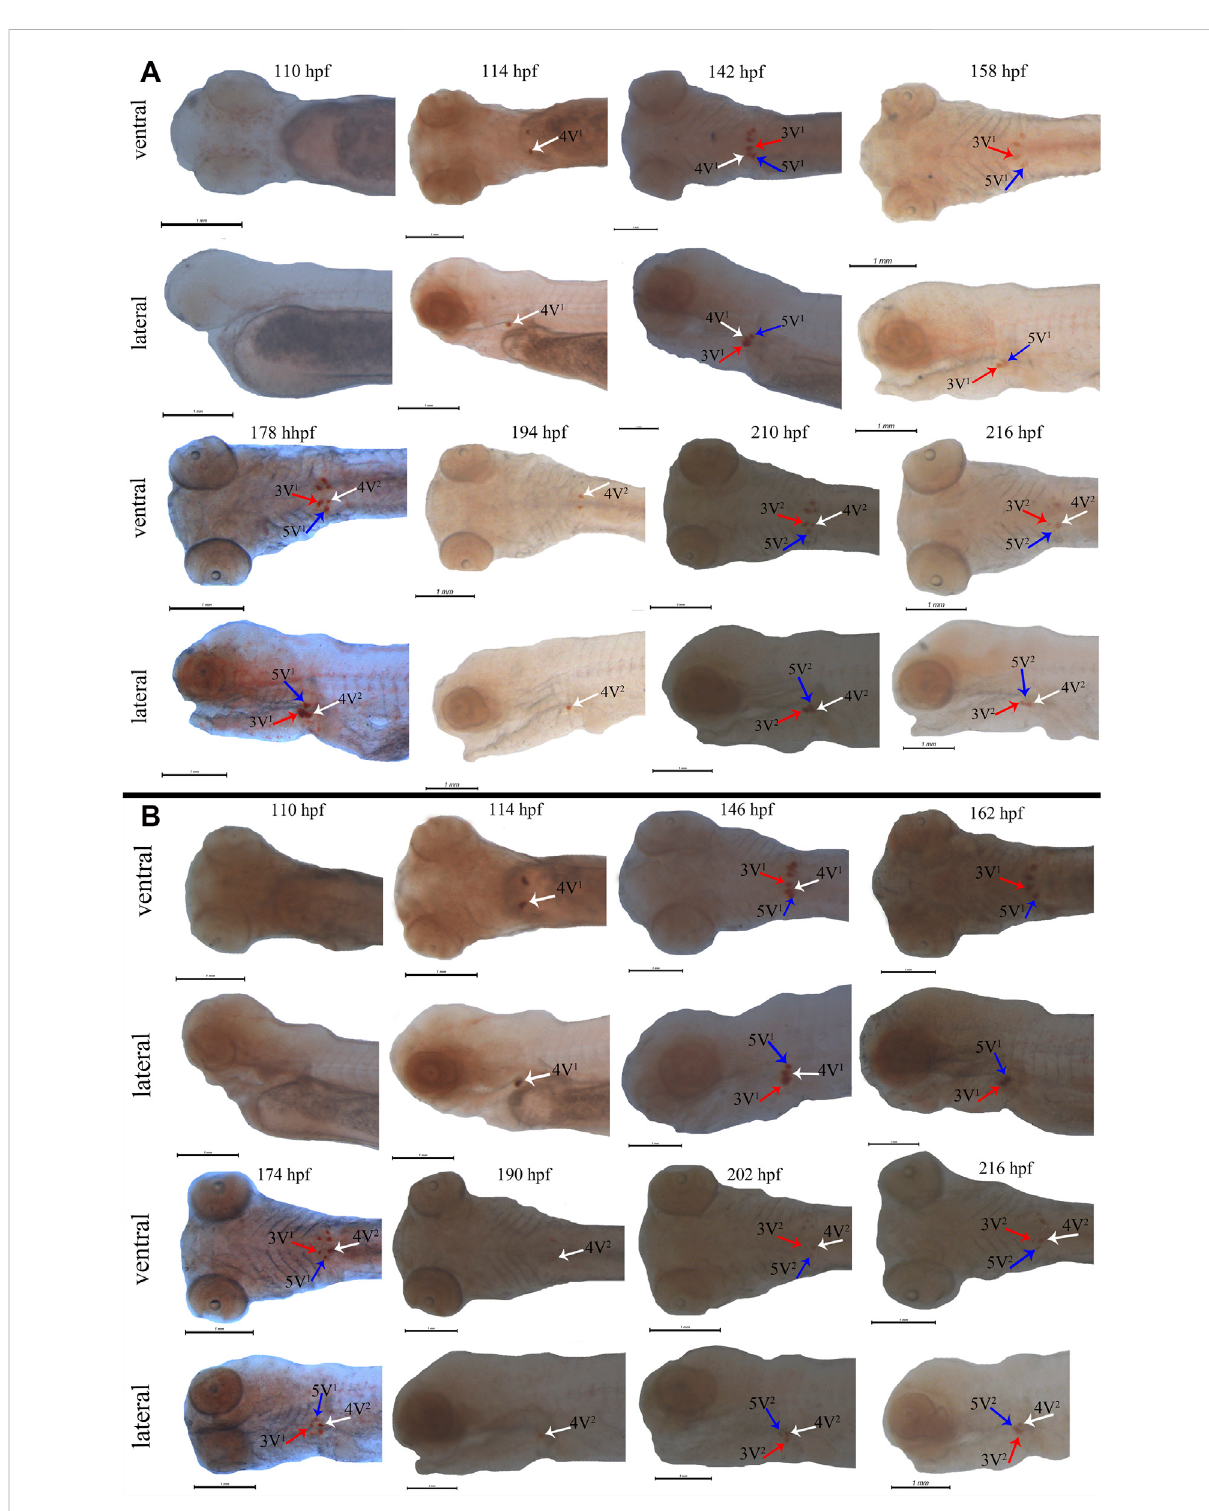
FIGURE 3 Whole-mount insitu hybridizationfor scpp5 inBT (A) andBSB (B) .At114 hpf,4V 1 activates scpp5 expressionbothinBTandBSB,and3V 1 and5V 1 strongly express scpp5 at 142 hpf in BT and 146 hpf in BSB. At 158 hpf and 162 hpf, the expression of scpp5 in 4V 1 disappears in BT and BSB, respectively, and 4V 2 expresses scpp5 at 178 hpf (BT) and 174 hpf (BSB). The absence of scpp5 expression in 3V 1 and 5V 1 occurs at 194 hpf (BT) and 190 hpf (BSB), and 3V 2 and 5V 2 express scpp5 at 210 hpf (BT) and 202 hpf (BSB), respectively. Scale bar = 1